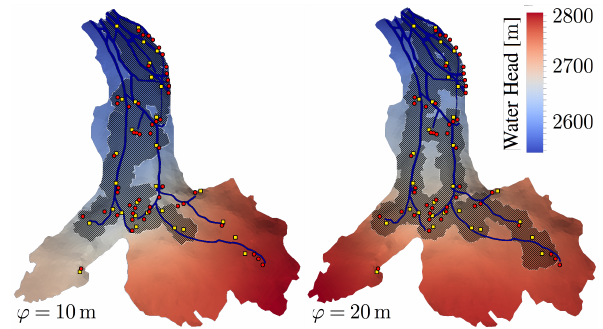
Fig. 10. Comparison between the modelled active EPL (black dashed zone) and the observed channel system (blue line) at the end of the melt season for two different values of the leakage length scale ϕ . The observed channel system and the corresponding moulin positions (red circles) for the summer of 1989 and 1990 are repro- duced from Sharp et al. (1993). The moulins observed during the 1993 season which are used for the simulations are marked by yel- low squares. The colour scale represents the water head of the IDS in metres. Parameters of the simulation are T i = 1 . 6 × 10 − 3 m 2 s − 1 and T e = 7 . 9 × 10 − 2 m 2 s − 1